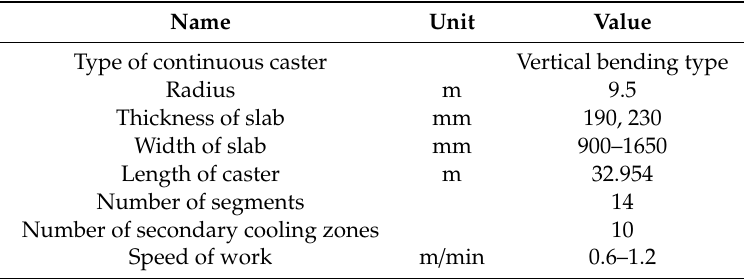
Table 7. Basic Structural parameters of the slab continuous caster.